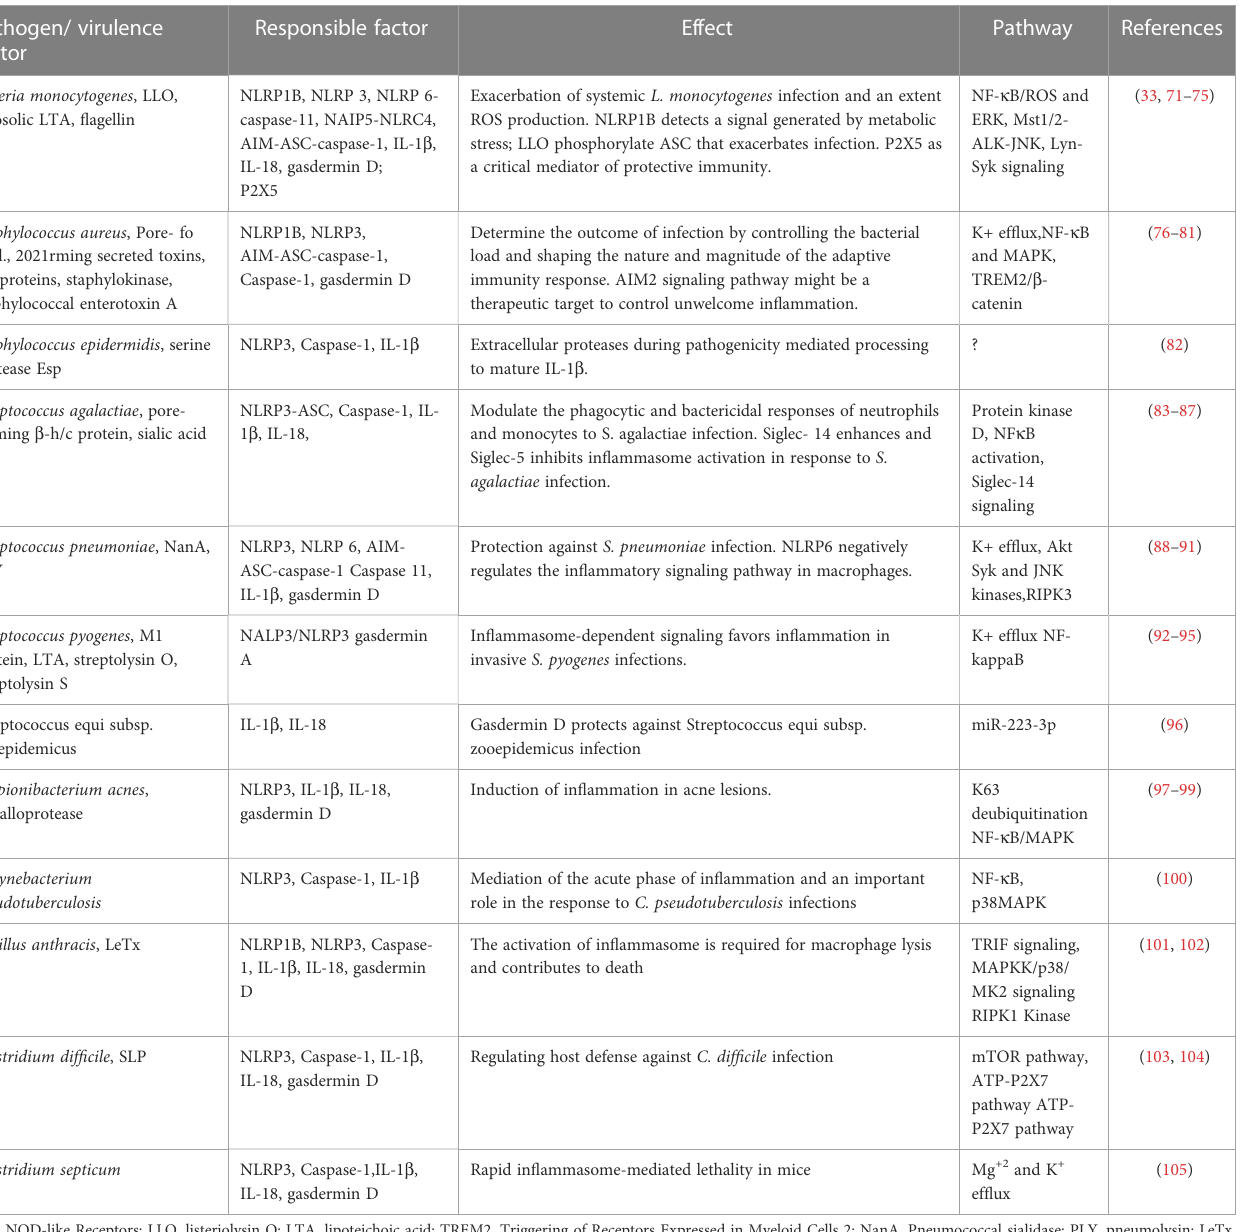
TABLE 1 In fl ammasome activation by Gram positive